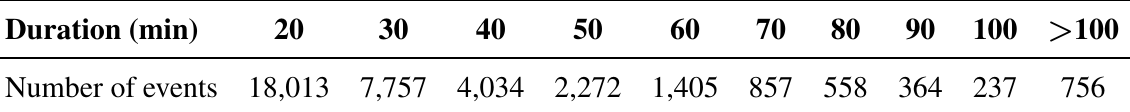
Table 2. Number of thunderstorms tracked in function of their duration.